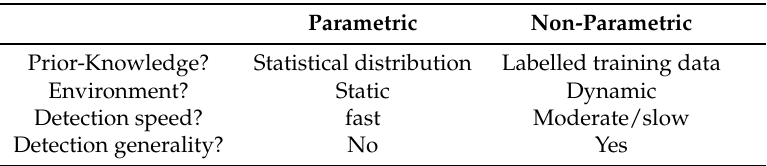
Table 1. Parametric vs. Non-parametric anomaly detection.